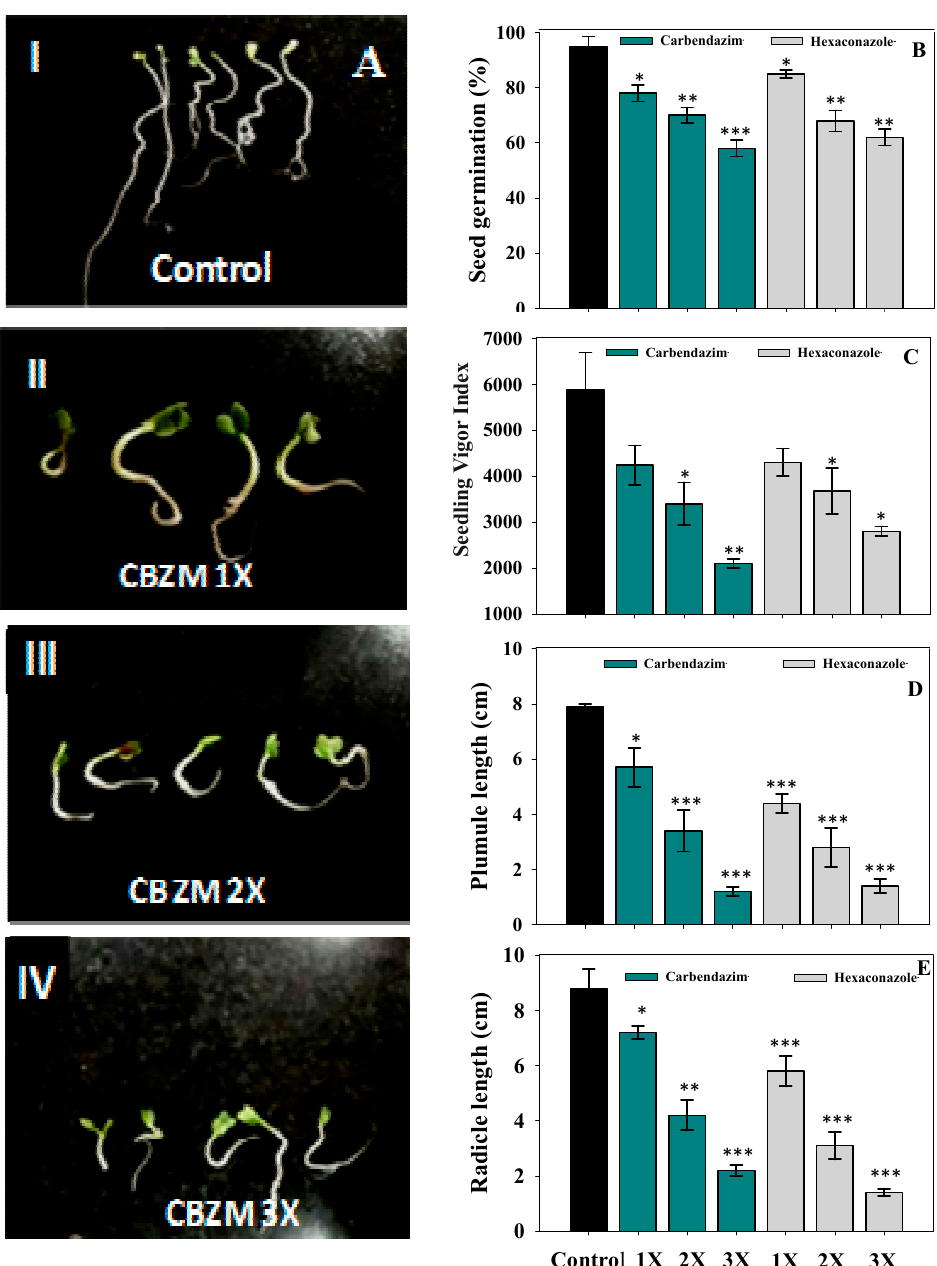
Figure 1. Effect of fungicide on seed germination efficiency and biological attributes of R. sativus : ( A ) Seeds germinated on agar untreated and treated with 1X, 2X and 3X concentrations of carbendazim (CBZM); ( B ) Effect of CBZM and hexaconazole (HEXA) on percent germination; ( C ) seedling vigor index; ( D ) plumule length; and ( E ) radicle length. In this and succeeding figures, histograms represent the mean value of three independent replicates ( n = 3) and error bars represent standard deviation (S.D). The asterisks *, ** and *** denote statistical significance at p < 0.05, p < 0.005 and p < 0.001, respectively computed by Student’s t -test. 1X, 2X and 3X denote the normal, two times and three times greater concentrations of